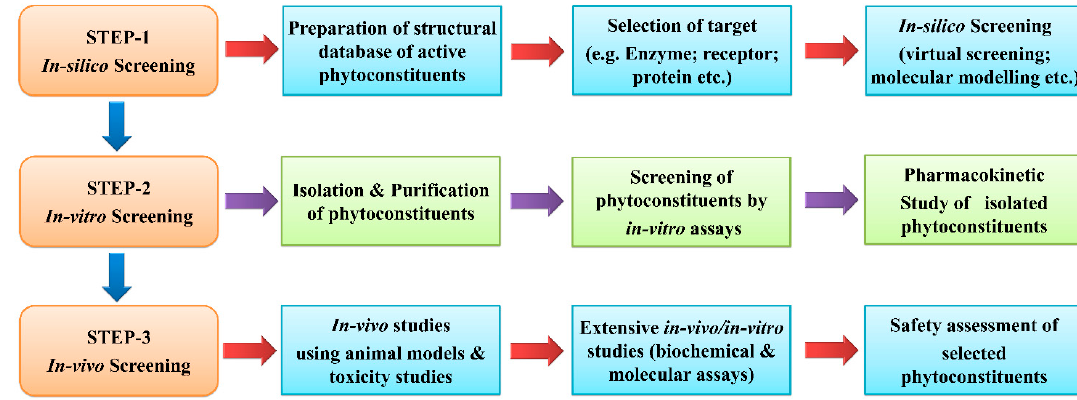
Figure 3. A systematic approach for preclinical evaluation of phytoconstituents.